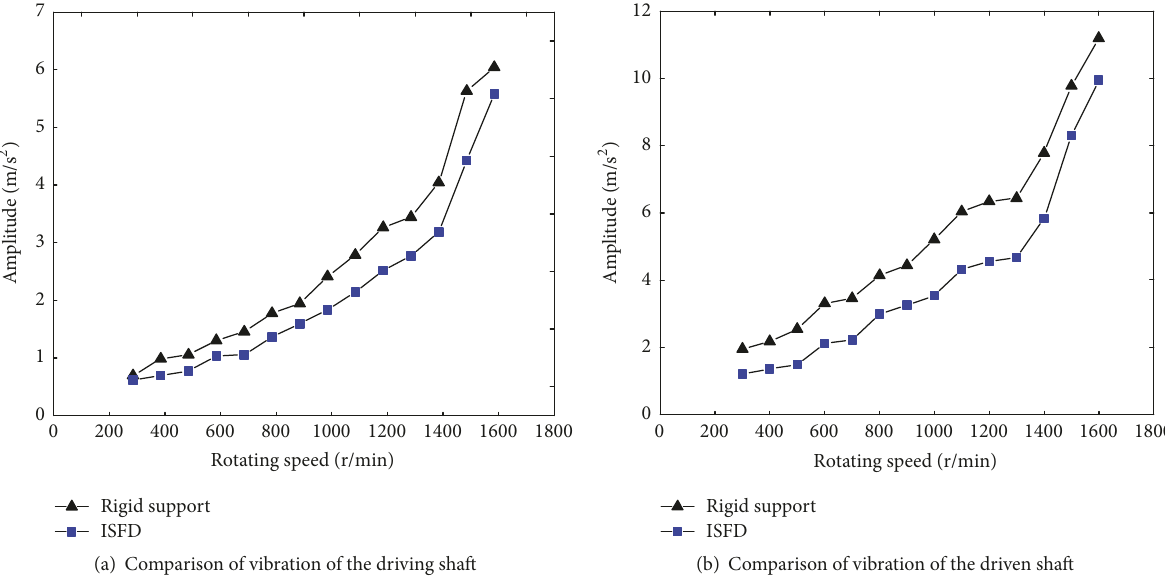
Figure 8: Curve of acceleration amplitude at measured points versus rotating speed with different supports.